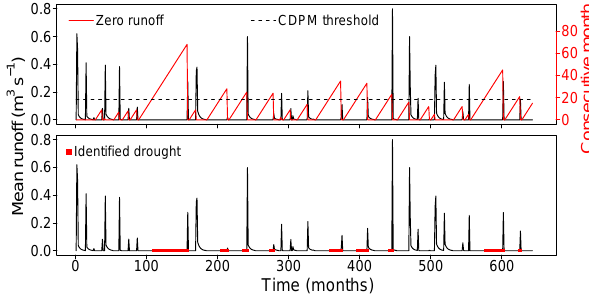
Fig. 5. Example of the consecutive dry period method (CDPM) to identify a hydrological drought for runoff data. Based on the monthly runoff data (black line), for months with zero runoff, its consecutive dry period number is calculated (red line). Based on the CDPM series, a given fixed exceedance threshold can be set (dashed line). Droughts are identified for those months that exhibit a CDPM value larger than the threshold (red